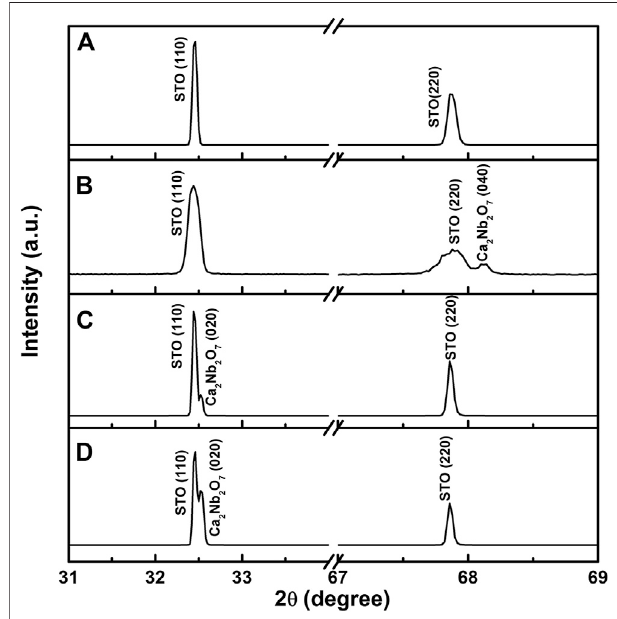
FIGURE 1 | XRD patterns of the STO substrate (A) , the as-deposited fi lms using stoichiometric Ca 2 Nb 2 O 7 target (B) , nonstoichiometric Ca 2 Nb 2 O 7 target with 5% Ca de fi ciency (C) and Nb de fi ciency (D)